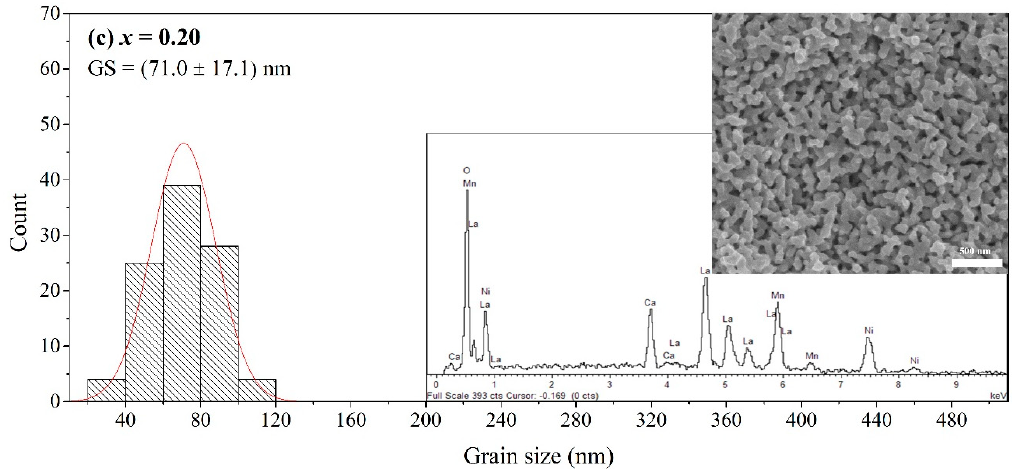
Figure 2. Grain size distribution histograms, FESEM micrographs and EDX spectra of ( a ) x = 0.00, ( b ) x = 0.10 and ( c ) x = 0.20.